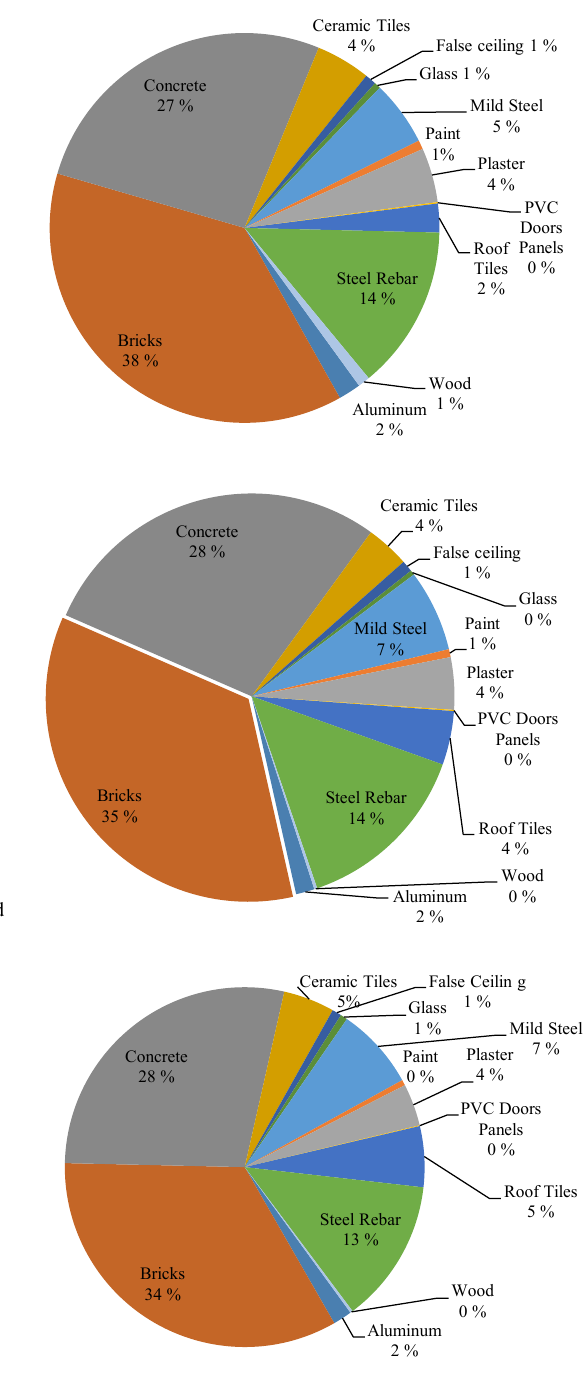
Fig. 2. Category wise percentage share of material in total CO 2